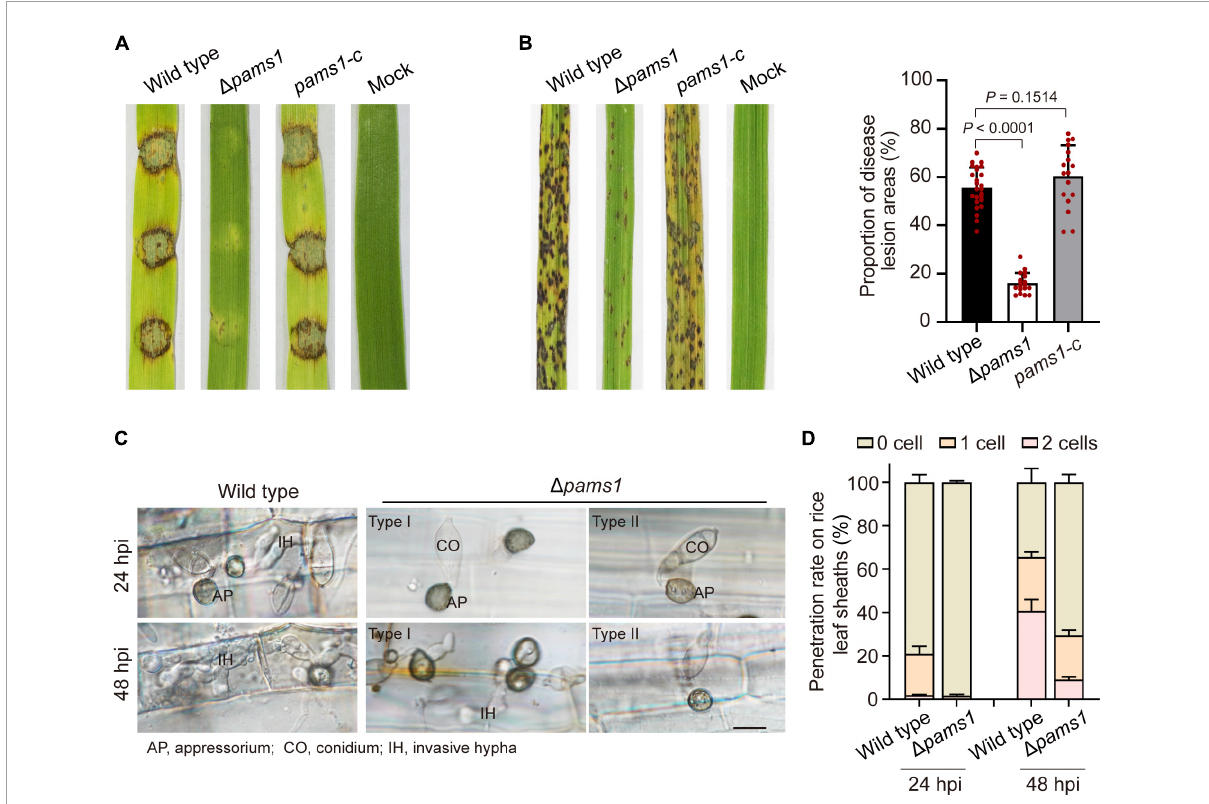
FIGURE5 PAMS1 is required for fungal virulence. (A) The 5-mm mycelial blocks were inoculated on leaf explants of barley. Images were taken at 4 dpi. (B) Left, virulence assays on rice by (cid:49) pams1 , its complementation strain pams1-c and the wild type. A suspension of 5 × 10 4 conidia per ml was sprayed onto seedlings of the rice cultivar CO-39. Images were taken at 7 dpi. Right, dot plot showing lesion areas calculated from a 5-cm zone of the infected rice leaf exhibiting the most serious disease lesions in each seedling. (C) Host penetration by appressoria and invasive hyphal growth on rice leaf sheaths at 24 and 48 hpi. Type II abnormal appressoria of (cid:49) pams1 were unable to invade rice tissue, and the invasion of type I abnormal appressoria into host tissue was delayed until 48 hpi. Scale bar, 10 µ m. (D) Percentages of appressoria with invasive hyphae that infected 0 to 3 rice cells ( n = 3) at 24 and 48 hpi. At least 150 appressoria were counted per replicate.